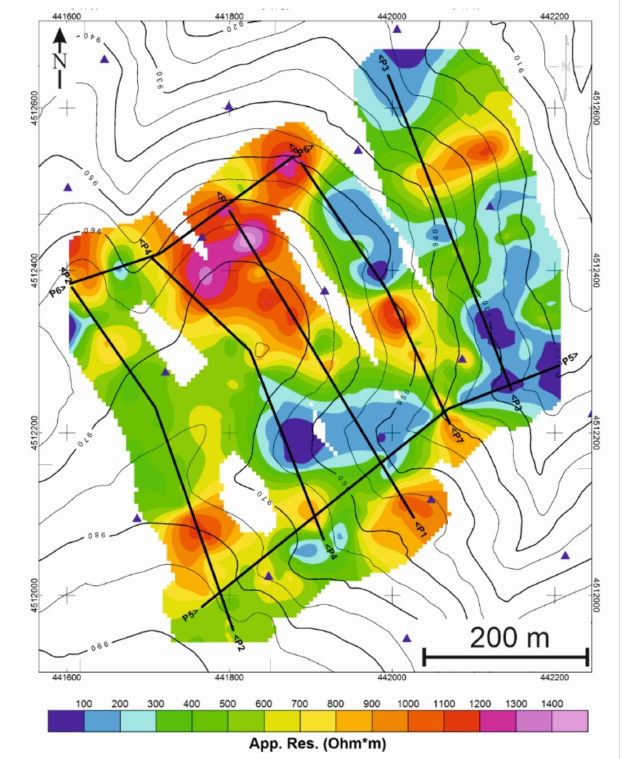
Figure 8. Location of the profiles where the tomographic resistivity inversion has been